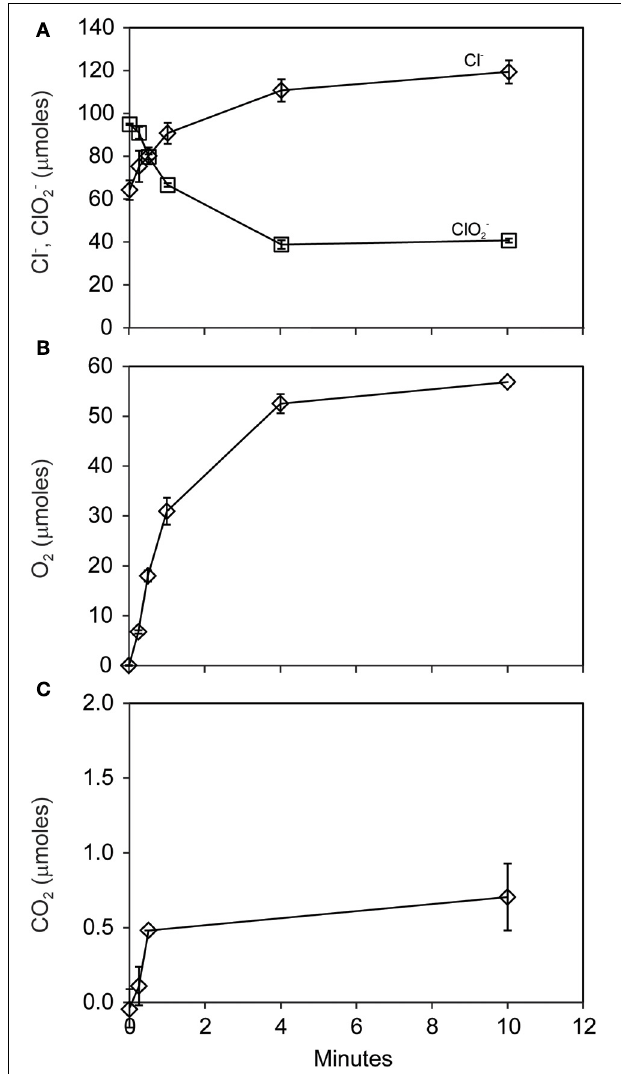
FIGURE 3 | Short-term course of reaction of D. agitata CKB following addition of 10mM ClO − 2 , showing loss of ClO − 2 (squares) and production of Cl − (A) and production of O 2 (B). A minor amount of CO 2 was produced (C) . Symbols represent the mean and standard deviation of triplicate measurements. Absence of bars indicates that the error is smaller than the symbol size.